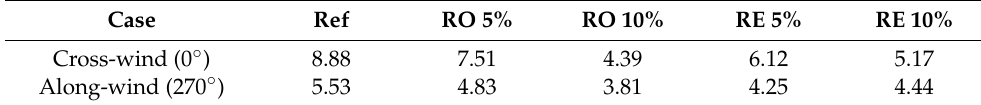
Table 3. The comparison of wind-induced moments in y direction (Unit: 10 9 N · m).